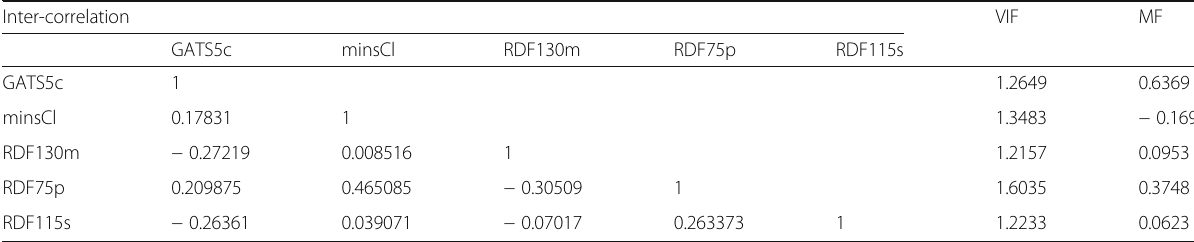
Table 4 Pearson ’ s correlation, VIF, and MF of the descriptors in the model